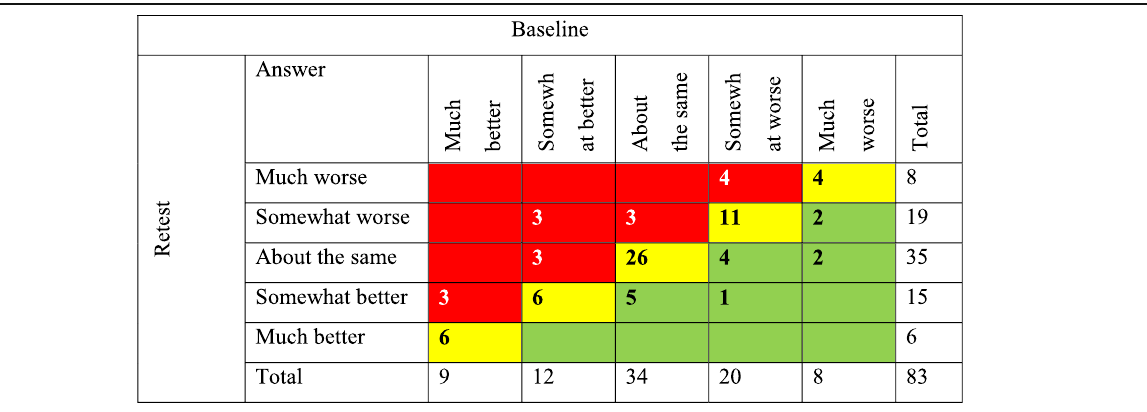
Table 4 Test-retest reliability: Health change item ratings for dialysis patients at baseline and retest